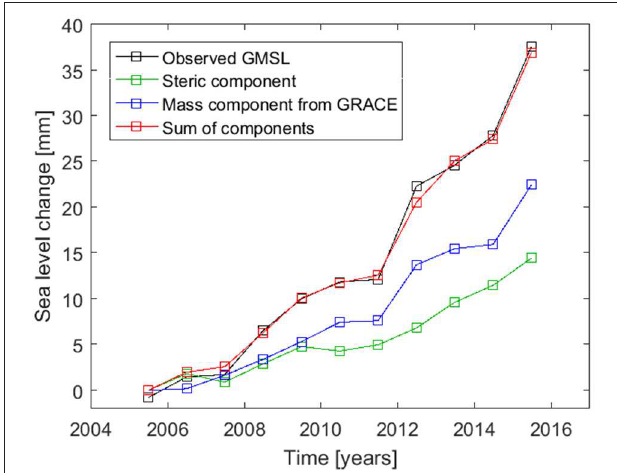
FIGURE 6 | The sea level budget over the golden era, using GRACE-based estimates of ocean mass change. The ensemble mean annual time series published by WCRP Global Sea Level Budget Group (2018) are